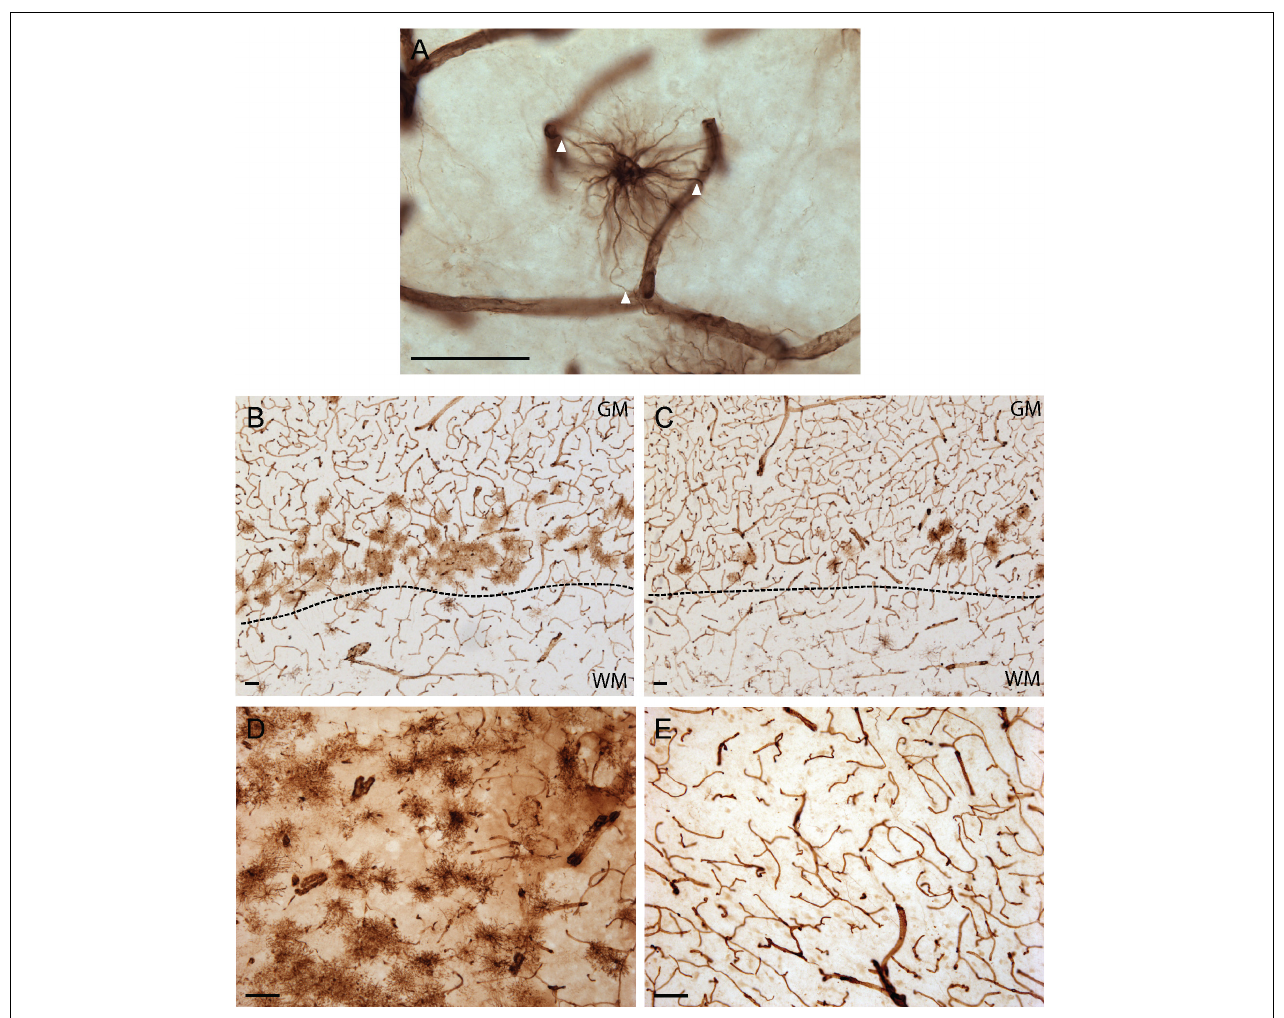
FIGURE 1 | Vimentin immunohistochemistry strongly labels blood vessels and astrocytes in healthy adult human brain. (A) Example of a VIM-IR astrocyte in the caudate nucleus juxtaposed to and contacting (arrowheads) VIM-IR blood vessels. (B) VIM-IR astrocytes in the prefrontal cortex gray matter outnumbered those in white matter and are clustered along the gray/white matter boundary (dashed line). (C) Although distributed in a similar pattern along the gray/white matter boundary (dashed line), fewer VIM-IR astrocytes were observed in the primary visual cortex compared to the prefrontal cortex. (D) VIM-IR astrocytes were most abundant in the caudate nucleus. (E) VIM-IR astrocytes were almost completely absent from the mediodorsal thalamus. Scale bars = 50 µ